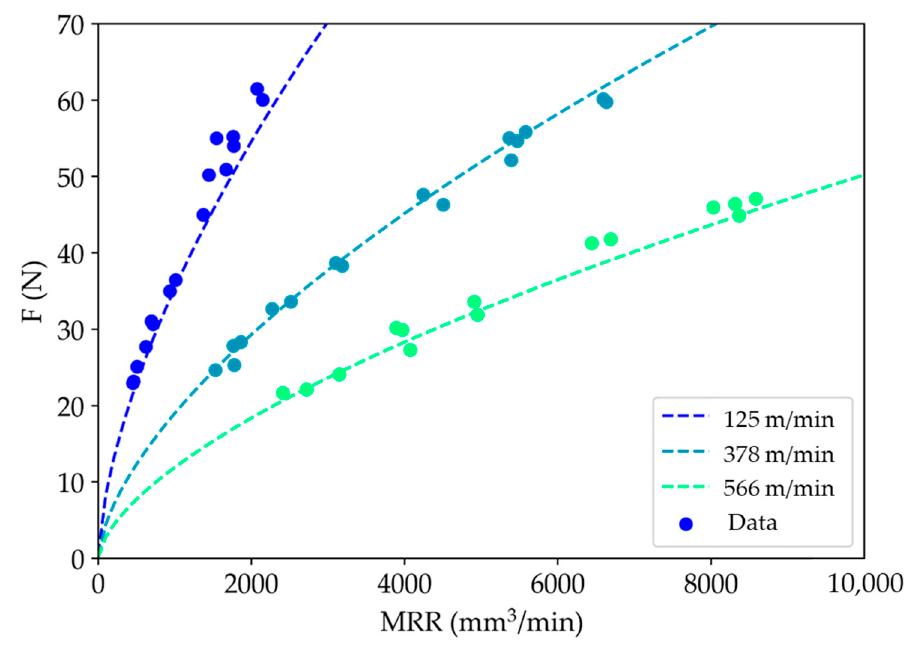
Figure 8. Average force module predicted (dashed lines) and experimental data against the material removal rate ( MRR ) as a function of the cutting speed ( V c ).